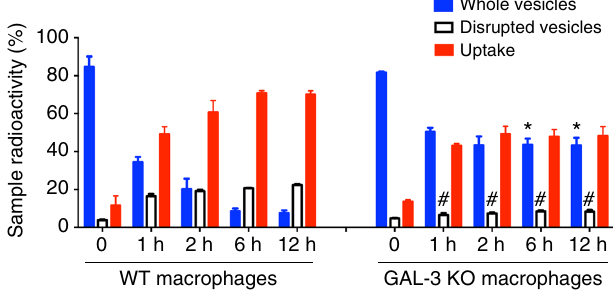
Fig. 8 Gal-3 is important for disruption and internalization of C . neoformans EVs by macrophages. Puri fi ed radiolabeled EVs were added to cultures of C57BL6 WT or Gal-3 − / − macrophages. After 1, 2, 6, or 12 h post EVs addition, the radioactivity recovered from the macrophages (adhered cells, uptake, red bars), intact vesicles (pellet, blue bars), and disrupted vesicles (supernatant, white bars) were counted by